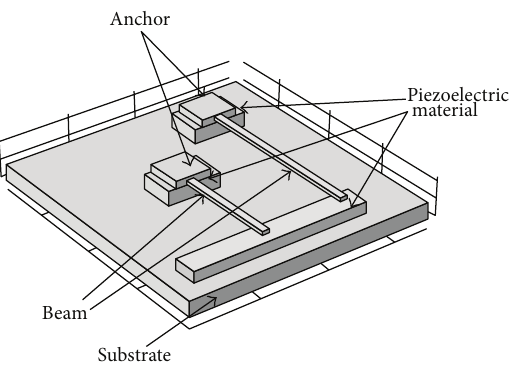
Figure 2: Layout of simulated cantilever design.